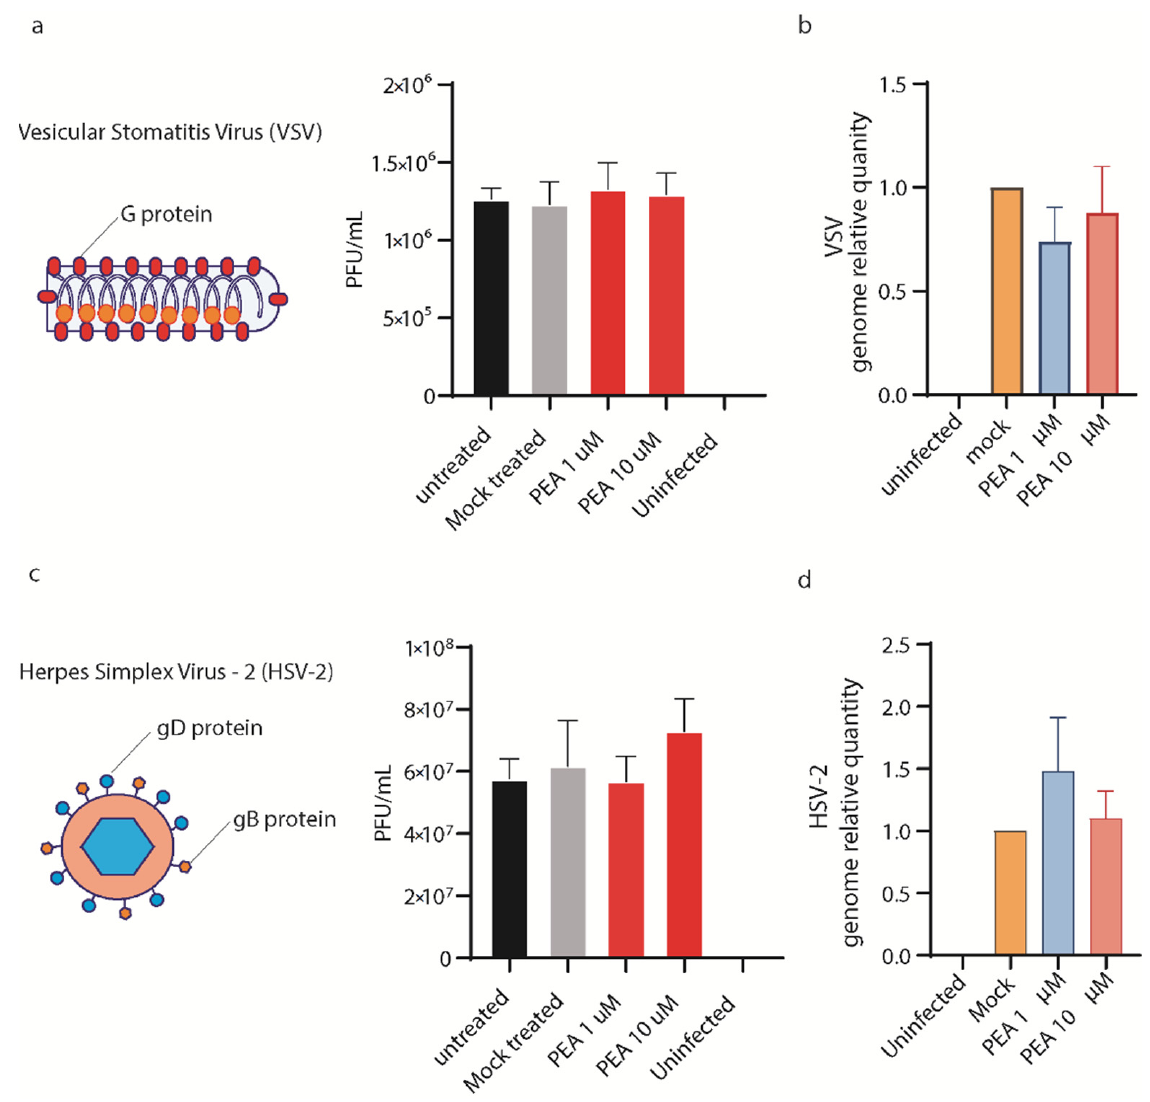
Figure 9. PEA does not reduce VSV and HSV-2 entry in Huh-7 cells. ( a ) (left panel) Schematic illustration of VSV. (right panel) Virus yield reduction assay performed using PEA at 1 and 10 μ M. ( b ) VSV genome relative quantity measured by qRT-PCR in cells treated or not with PEA after infection. ( c ) (left panel) Schematic illustration of HSV-2. (right panel) Virus yield reduction assay performed using PEA at 1 and 10 µ M. ( d ). HSV-2 genome relative quantity measured by qRT-PCR in cells treated or not with PEA after infection. Data are expressed as means ± SD and were analyzed using a one-way ANOVA (n = 3).